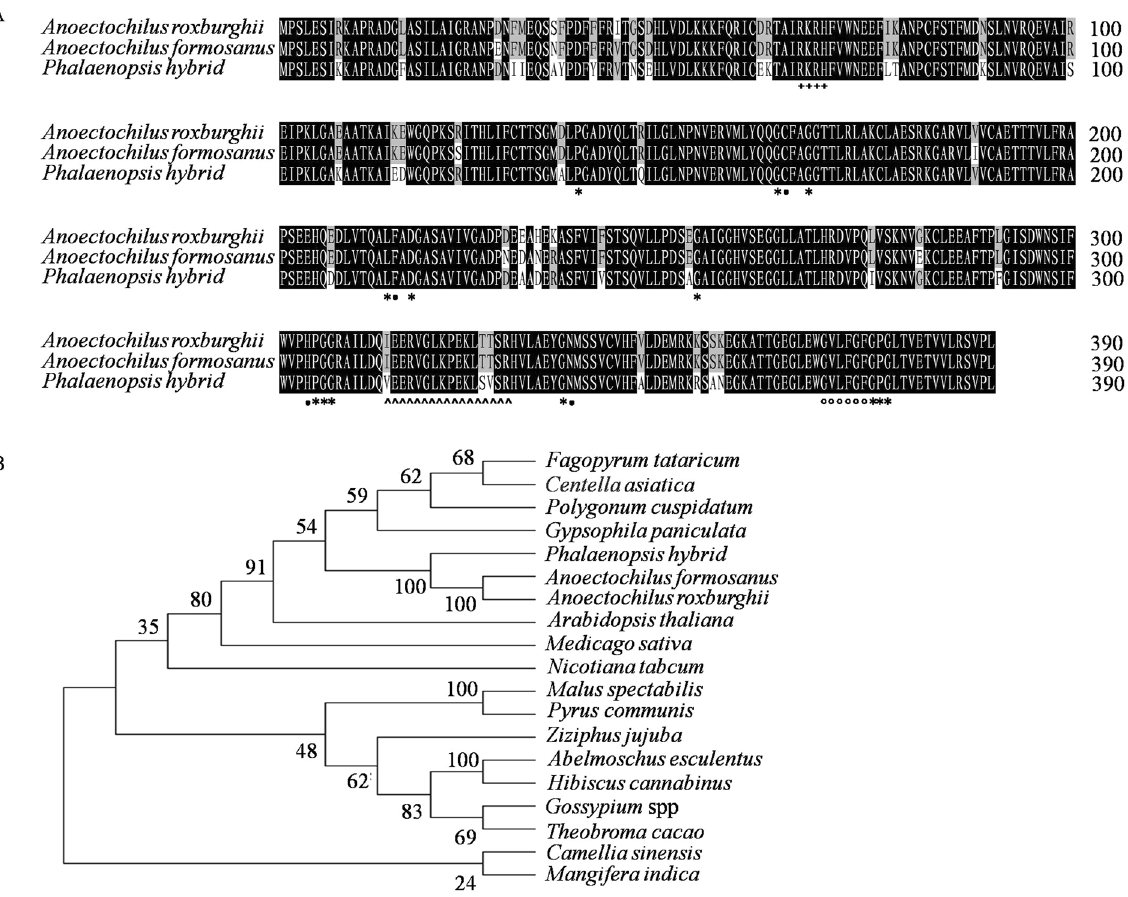
Figure 1. Alignment and phylogenetic tree of putative proteins of gene CHS of A. roxburghii and A. formosanus with relative species. ( A ) Alignment among the putative proteins of gene CHS of A. roxburghii , A. formosanus and P. hybrida . The black, gray and white backgrounds represent similarity of 100%, 66.7% and 0%, respectively. The asterisks ( * ), the black dots ( • ), the hollow dots ( ○ ), the hollow triangles ( △ ) and the plus ( + ) represent the activation sites, the catalytic residues, the conserved residues, the malonyl-coenzyme A binding motif and the nuclear localization signal, respectively. ( B ) Phylogenetic tree among the putative proteins of gene CHS of 19 relative